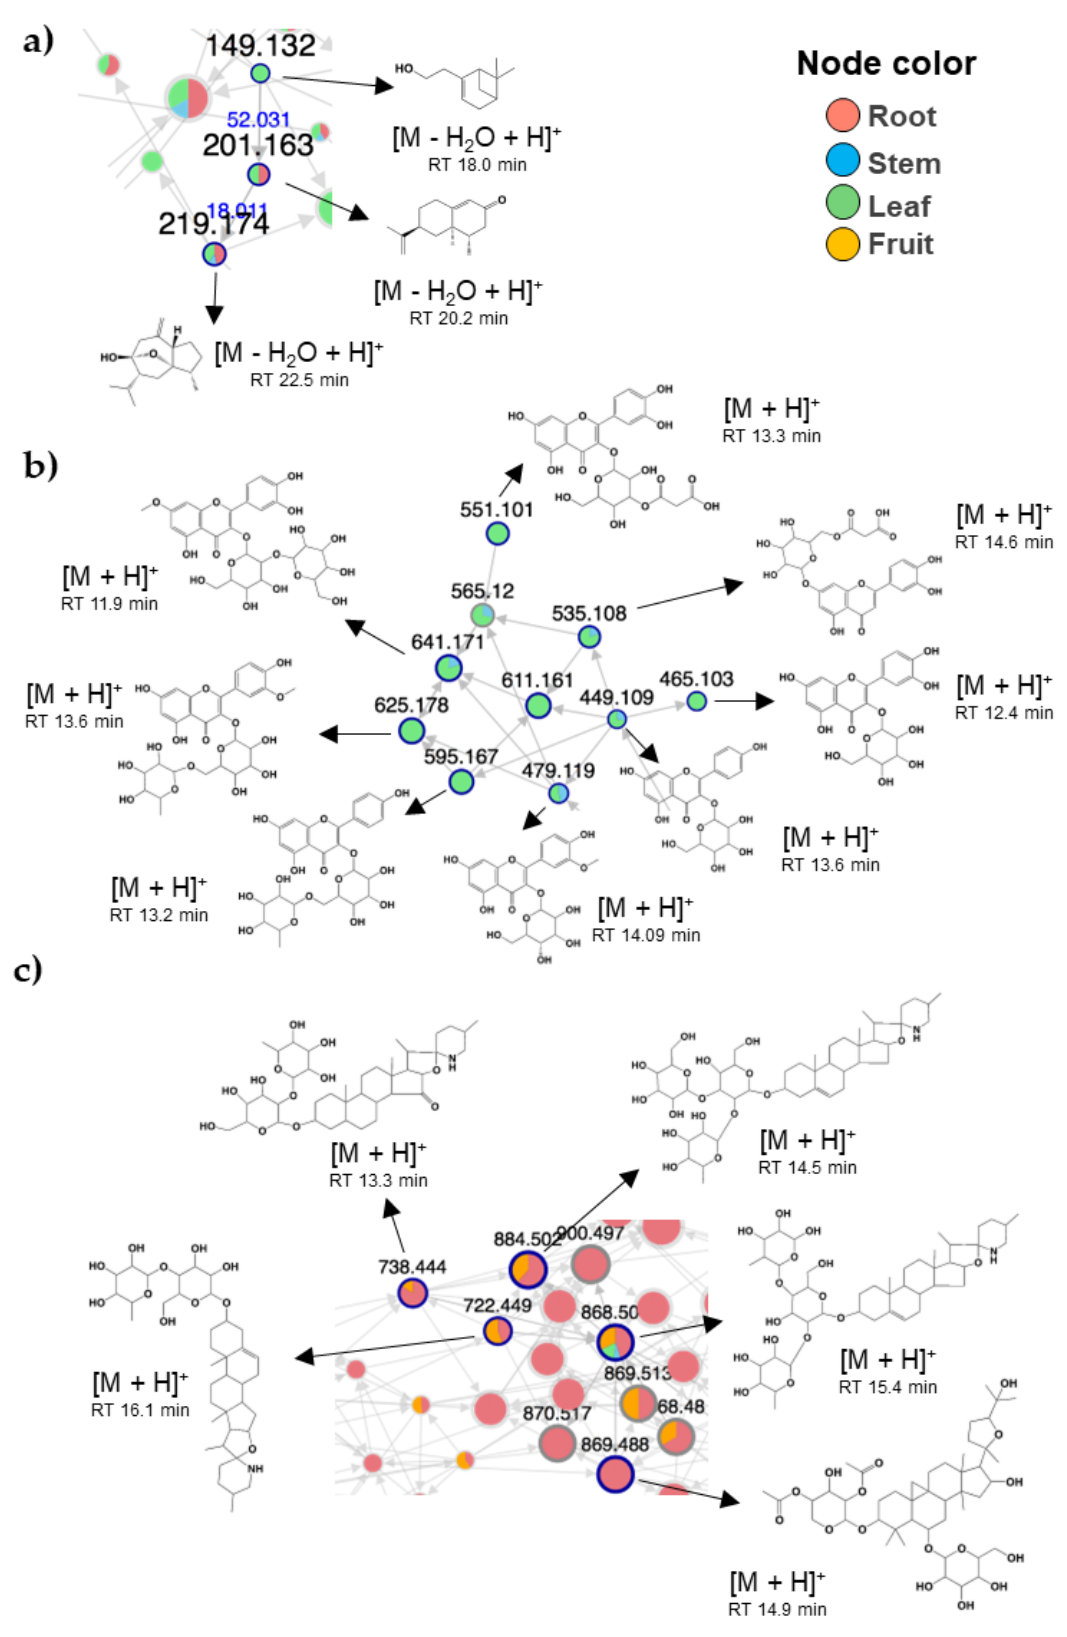
Figure 5. Principal group of metabolites identified in eggplant residues. Select clusters containing putatively identified metabolites and analogs. ( a ) Terpenes; ( b ) glycosides flavonoids; ( c ) sapo- nins/alkaloids.